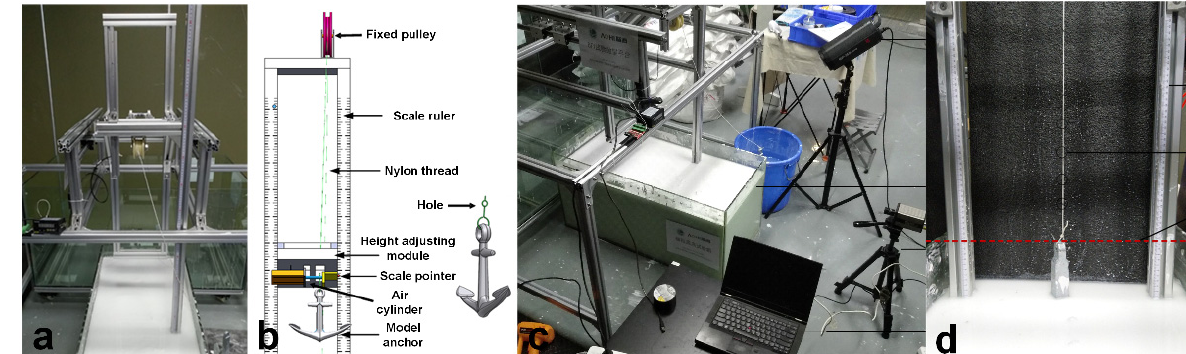
Figure 10. ( a ) The experiment platform, ( b ) height-adjustable anchoring platform, ( c ) high-speed image acquisition system, and ( d ) depth measurement module.